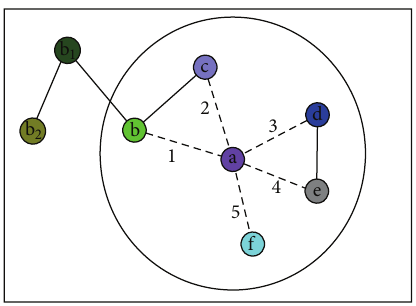
Figure 4: An example for edge selection rules.